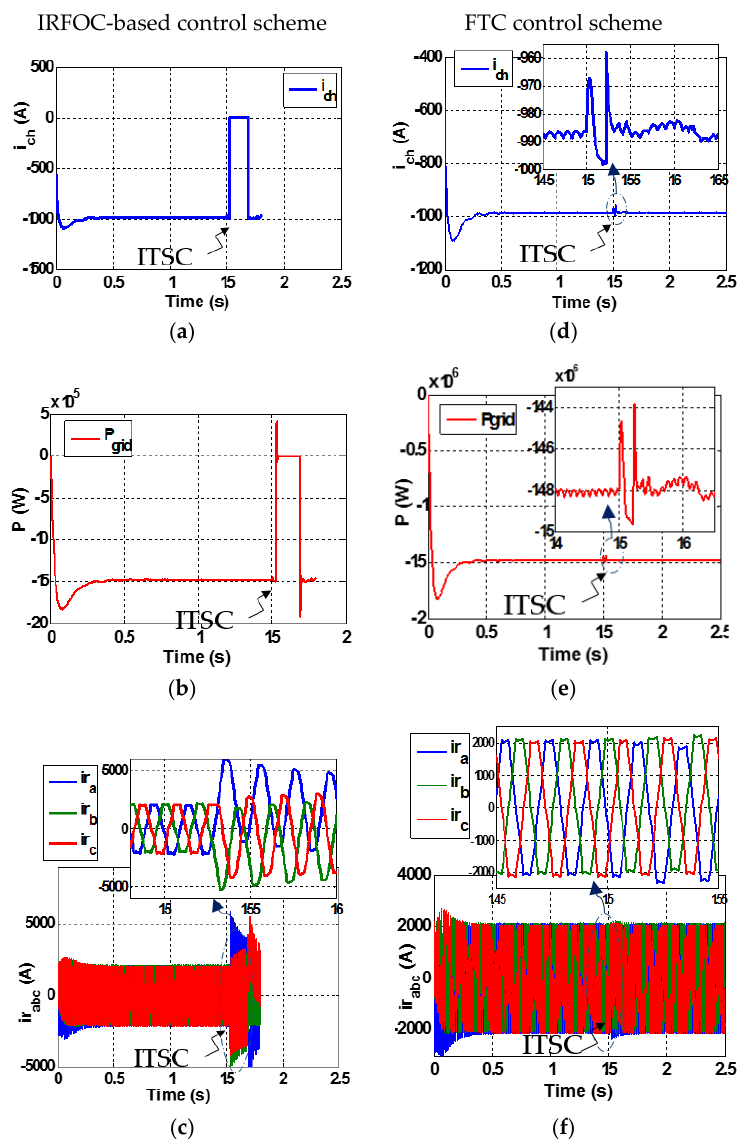
Figure 10. Simulation comparison between the components of the IRFOC-based control scheme (left side) and FTC-based control scheme (right side): ( a , d ) stator-side converter current i ch ; ( b , e ) supplied power P g to the grid; and ( c , f ) three-phase grid currents i rabc with their zooms at t = 1.5 s of wind turbine system IG with ITSC fault of 80% of s 1 -phase.